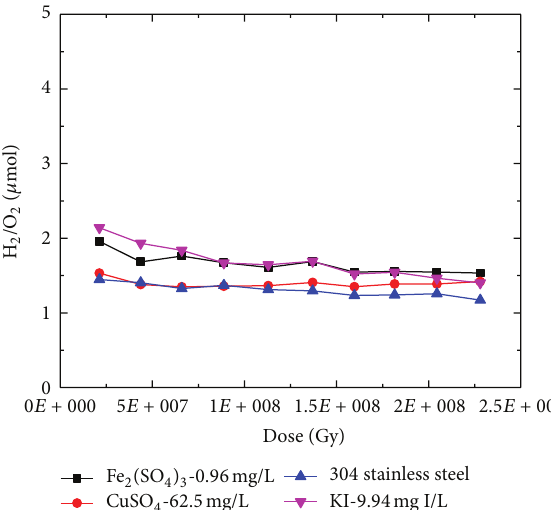
Figure 10: Hydrogen to oxygen ratios measured during irradiation of 126g-U/L UO 2 SO 4 solutions in the presence of potential peroxide catalysts at the Van de